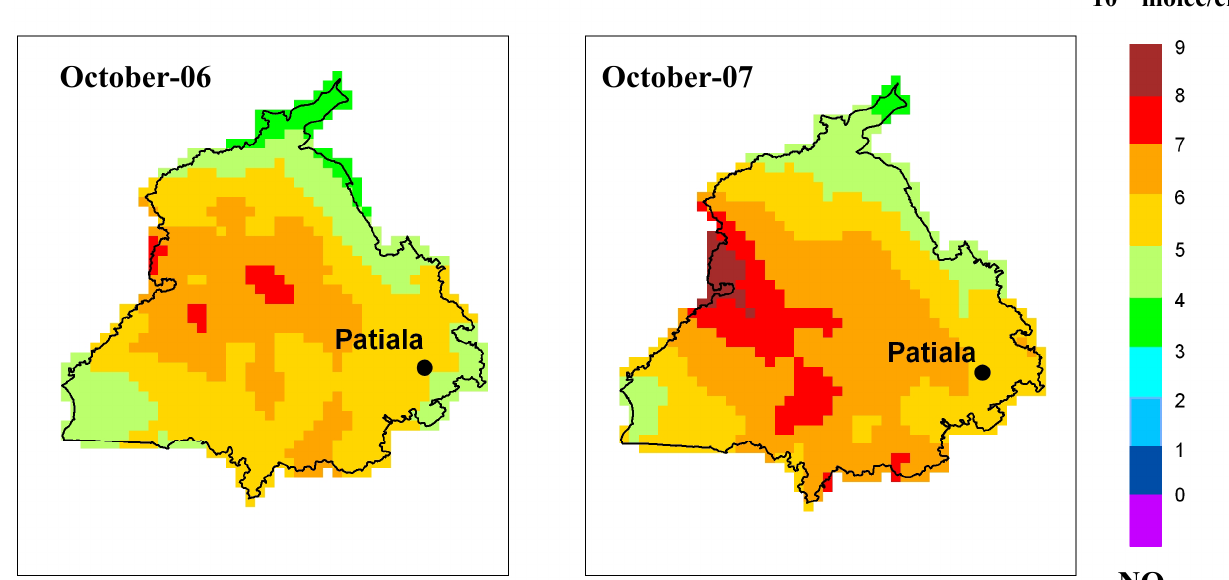
Fig. 10. Spatial variation of OMI-NO 2 over Punjab state, India during October 2006 and